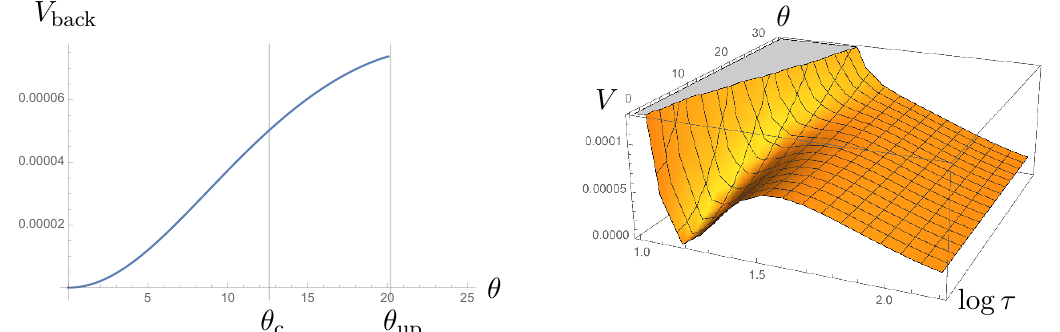
Figure 2 . We plotted on the left the backreacted potential V back ( (cid:18) ) including the uplift and on the right a slice of the potential V ( (cid:18); s 0 ( (cid:28) ) ; (cid:28) ). Both pictures show the destabilization of the in(cid:13)ationary